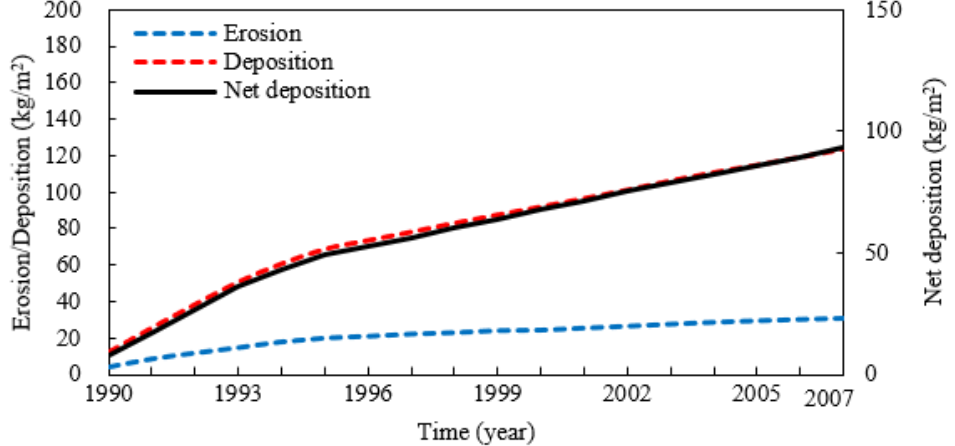
Figure 16. Amounts of erosion (blue dashed line), deposition (red dashed line) and net deposition (solid black line) per unit area for the QL system from 1990 to 2007. 4.5. 2008~2018 During 2008~2018, the reclamation of QL attained a saturation situation, and the wa- terfront of the lagoon changed little compared to 1990~2007. A bridge was built at the entrance to lagoon to connect the two sides of the tidal channel. The top part of the tide gate was removed and the tidal channel was widened near the tidal inlet. The average width of the tidal channel increased from 110 m to 150 m. As is shown in Figure 17, the bathymetry of QL did not change significantly, but the overall bed elevation rose by 0.106